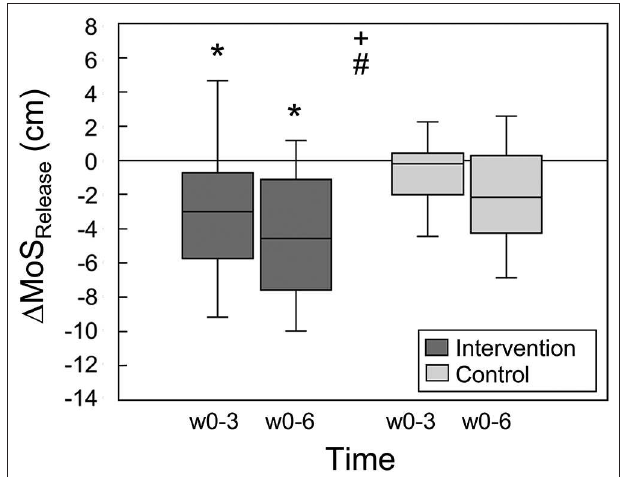
FIGURE 3 | Changes of the margin of stability at release ( 1 MoS Release ) during the simulated forward falls between weeks 0 and 3 as well as weeks 0 and 6 for the intervention ( n = 18) and control groups ( n = 14), respectively. Statistically significant main effect of + time and # group ( p < 0.05). *Statistically significant difference ( post-hoc analysis) to baseline, i.e., week 0 ( p < 0.05).